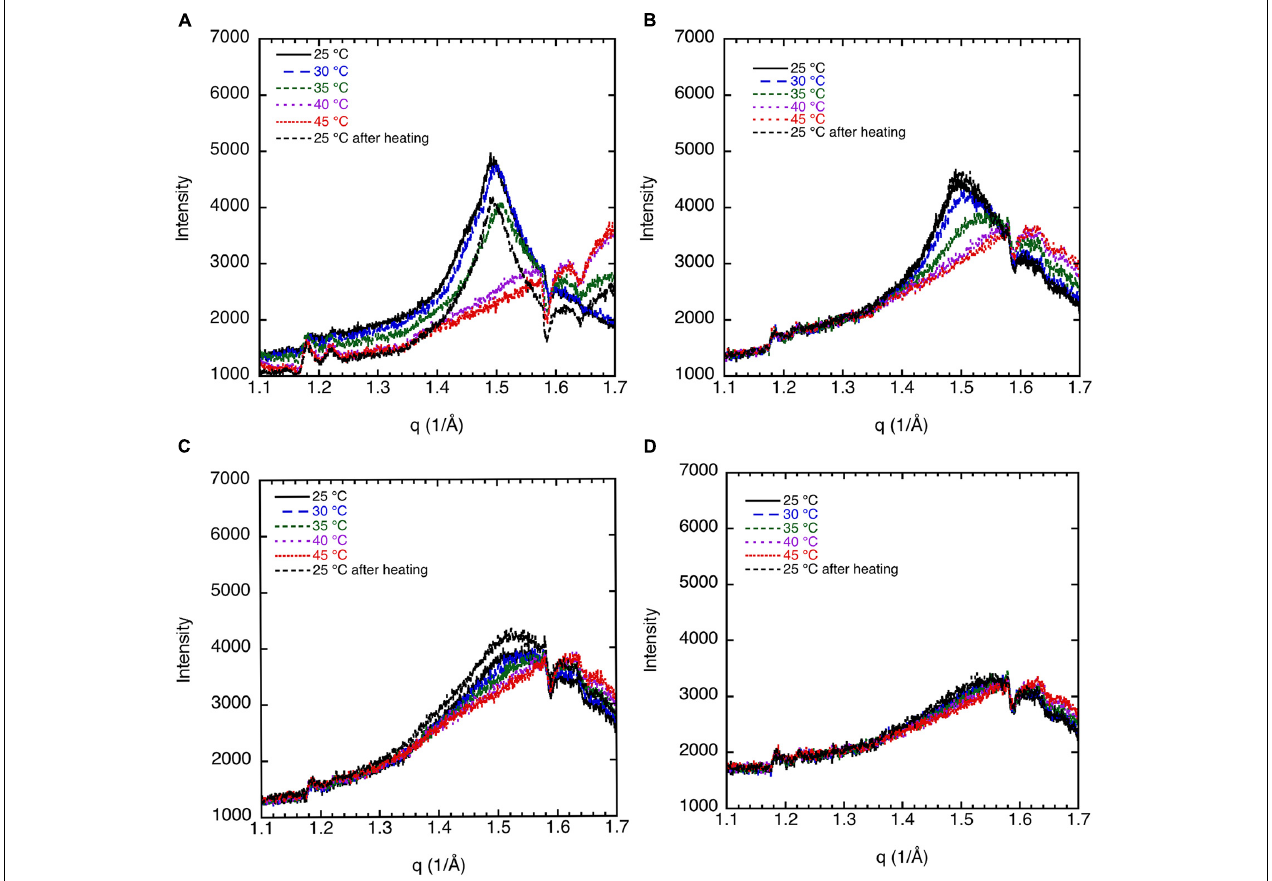
FIGURE 3 | The effect of cholesterol on the crystalline order of porcine brain sphingomyelin in 0.9 wt% (154 mM) NaCl and 1 mM CaCl 2 recorded at different temperatures by WAXD. (A) Sphingomyelin (70%) and no cholesterol (0% of lipid). Peak position corresponds to spacing of 4.20 Å at 25 ◦ C and 30 ◦ C, 4.17 Å at 35 ◦ C, while no peak at higher temperatures. (B) Sphingomyelin (65.1%) and 4.9% cholesterol (7% of lipid). Peak position corresponds to spacing of 4.20 Å at 25 ◦ C, 4.17 Å at 30 ◦ C, rounded peak at 35 ◦ C, while no peak was observed at higher temperatures. (C) Sphingomyelin (59.5%) and 10.5% cholesterol (15% of lipid). A rounded peak appears at 25 ◦ C, while no peak was observed at higher temperatures. (D) Sphingomyelin (56%) and 14% cholesterol (20% of lipid). No defined peak appears at any temperature.